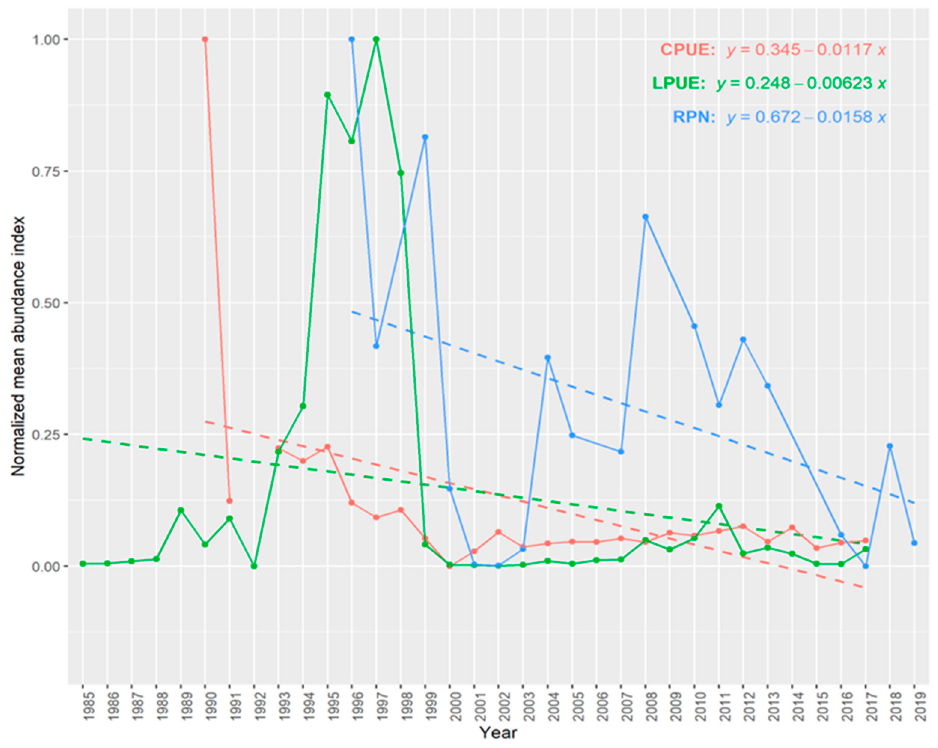
Figure 9. Min–max normalized mean abundance indices for different years of Lepidopus caudatus in the Azores. The abundance indices used were standardized CPUE (kg days at sea − 1 vessel − 1 ), LPUE (kg landing − 1 vessel − 1 ) and survey-derived RPN (ind. 10 − 3 hooks). The dashed lines represent the linear regressions for each abundance index. Table 3. ANCOVA results of differences in the direction of the linear models for the abundance indices. The covariate year interaction with the factorial variable abundance index represents the categories of CPUE, LPUE, and RPN. Signif. codes: 0 ‘***’ 0.001 ‘**’ 0.01 ‘*’. Mean Abundance ~ Year + Abundance Index + Year * Abundance Index